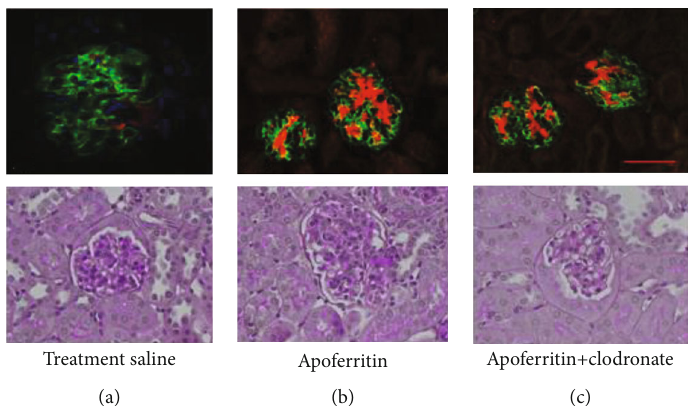
Figure 5: M ϕ s depletion reduces glomerular pathology in FH-dependent ICGN. Given are representative images of glomeruli from saline- treated (a), apoferritin-treated (b), and apoferritin+clodronate-treated FH-de fi cient mice. In (A), the sections are stained with C3 (green) and IgG (red), while (B) show sections stained with PAS. IgG deposits that were increased with apoferritin treatment remained unchanged, while the glomeruli looked closer to normal on macrophage depletion.